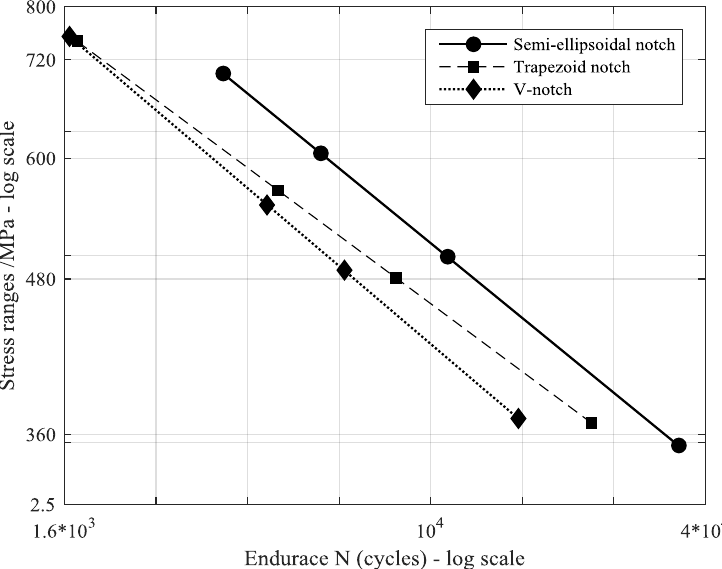
Figure 20. Logarithmic S-N curve of steel wire with different notches of different shapes.